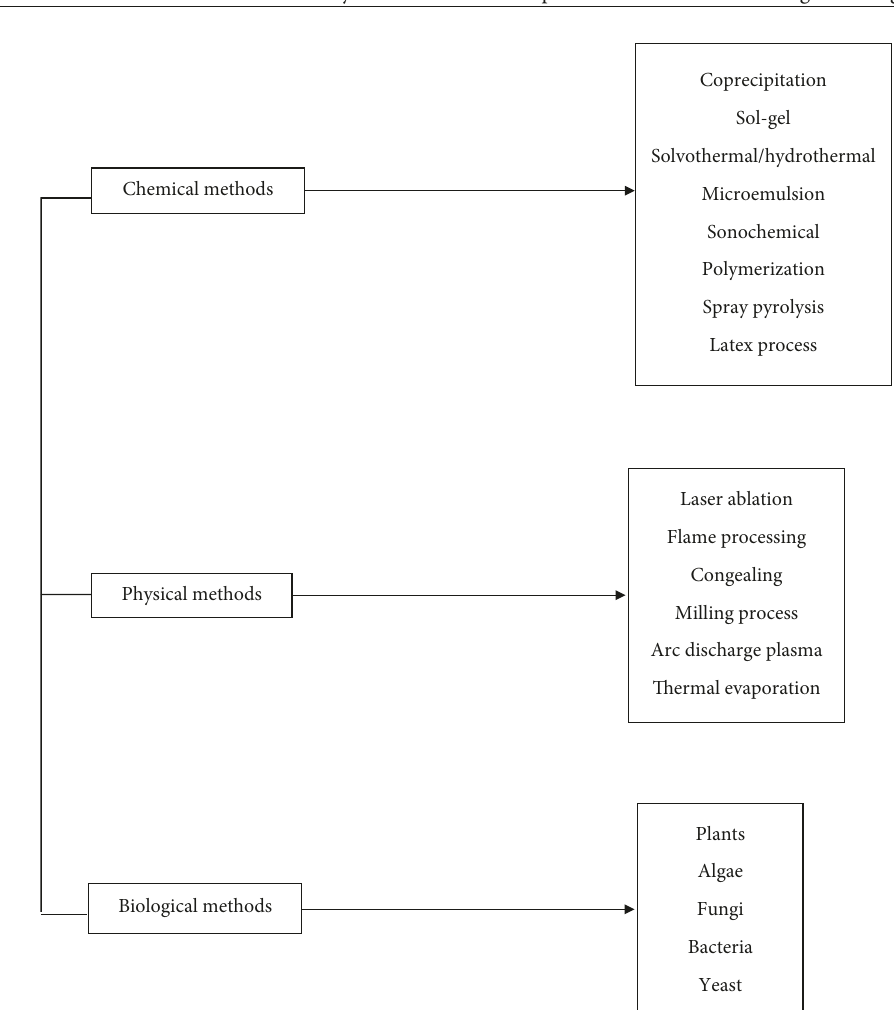
Figure 3: Different routes for synthesis of